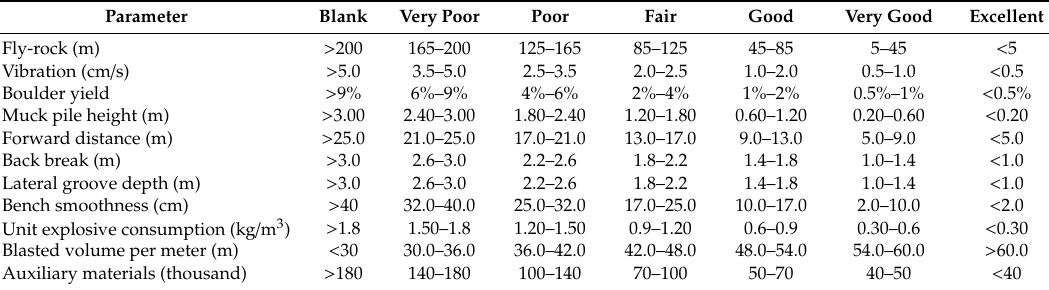
Table 3. The default data ranges of parameters in BEES.